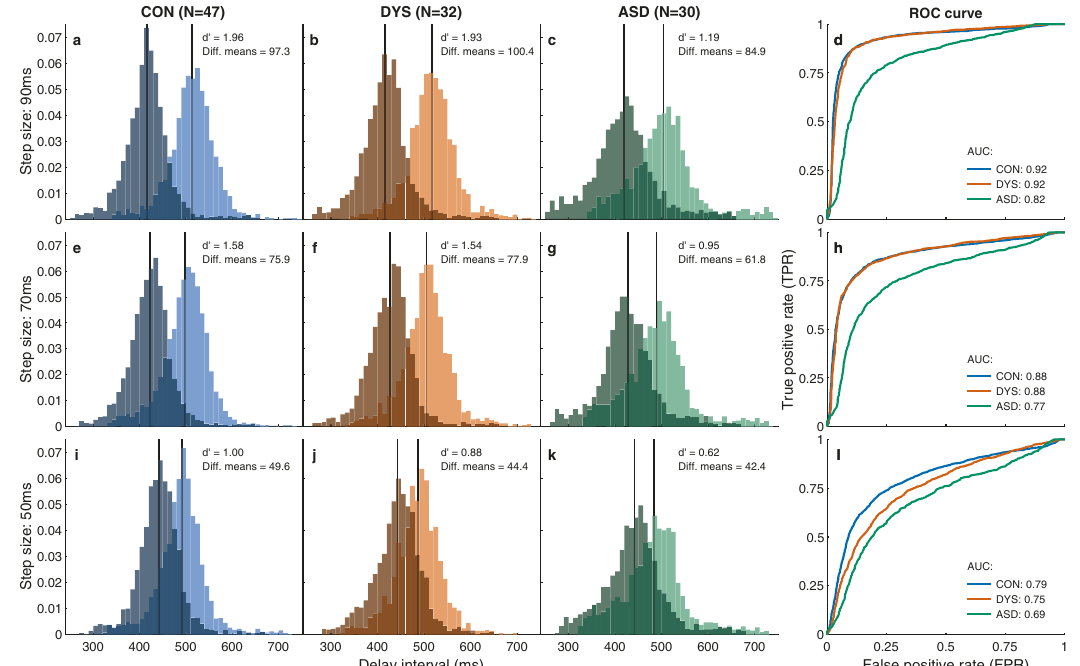
Fig. 5 Distributions of delay intervals 5 – 12 taps after the tempo switch show that asynchronies in the autism group remain uncorrected. a – c , e – g and i – k show group delay intervals probability density functions separately for the longer tempo (light color) and shorter tempo (dark color), for each tempo- change condition (90 ms — top, 70 ms — middle, 50 ms — bottom) and for each population (CON (control, neurotypical) — blue, DYS (dyslexia) — red, ASD (autism) — green). The mean of each distribution is denoted by a black vertical line. Values of d ′ and the difference between the means (diff. means) are in the top right corner. d , h , l show for each group the receiver-operator-curves (ROC), and area under the curve (AUC) for classi fi cation between delay intervals under the two tempos. In the 70 and 90 ms step-sizes, the measures of dyslexia and neurotypical groups nearly overlap, while the values for the ASD group are smaller, re fl ecting reduced updating to changes in external tempo. For the small 50 ms step-size, the dyslexia group values are midway between the neurotypical and autism values, though this difference was not signi fi cant (see main text). Source data are provided as a Source Data fi